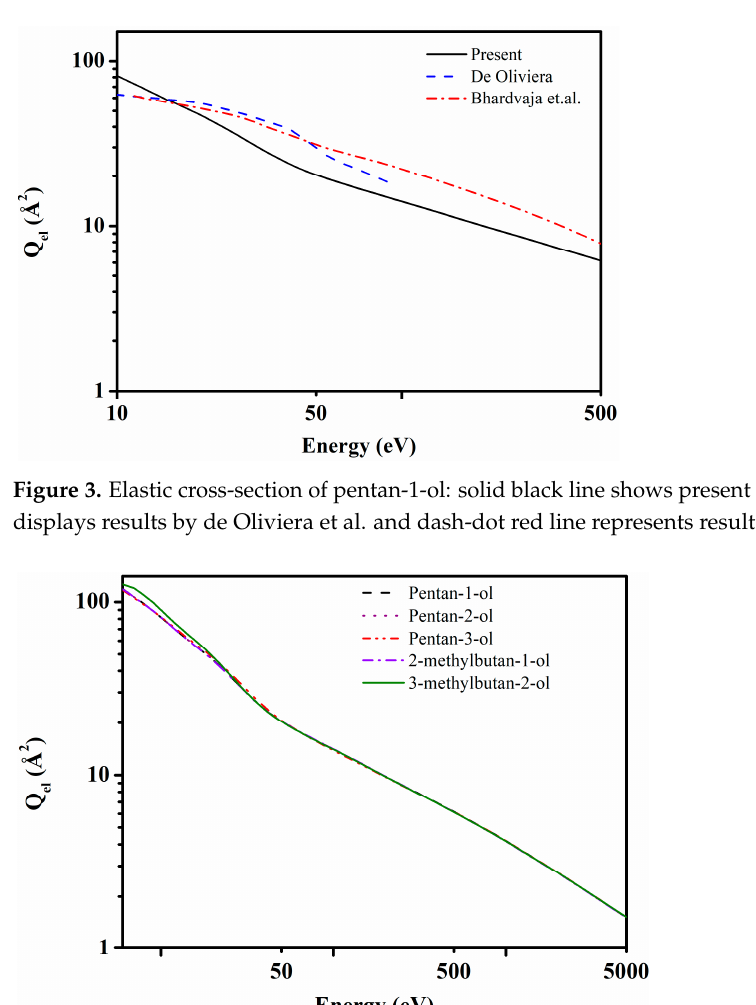
Atoms 2021 , 9 , x FOR PEER REVIEW 7 of 12 Figure 4. Elastic cross-section of pentanol isomers (present): black dashed line is for pentan-1-ol, purple dotted line represents pentan-2-ol, red dash-dot-dot line represents pentan-3-ol, violet dash-dot line represents 2-methylbutan-1-ol and green solid line represents 3-methylpropan-2-ol.